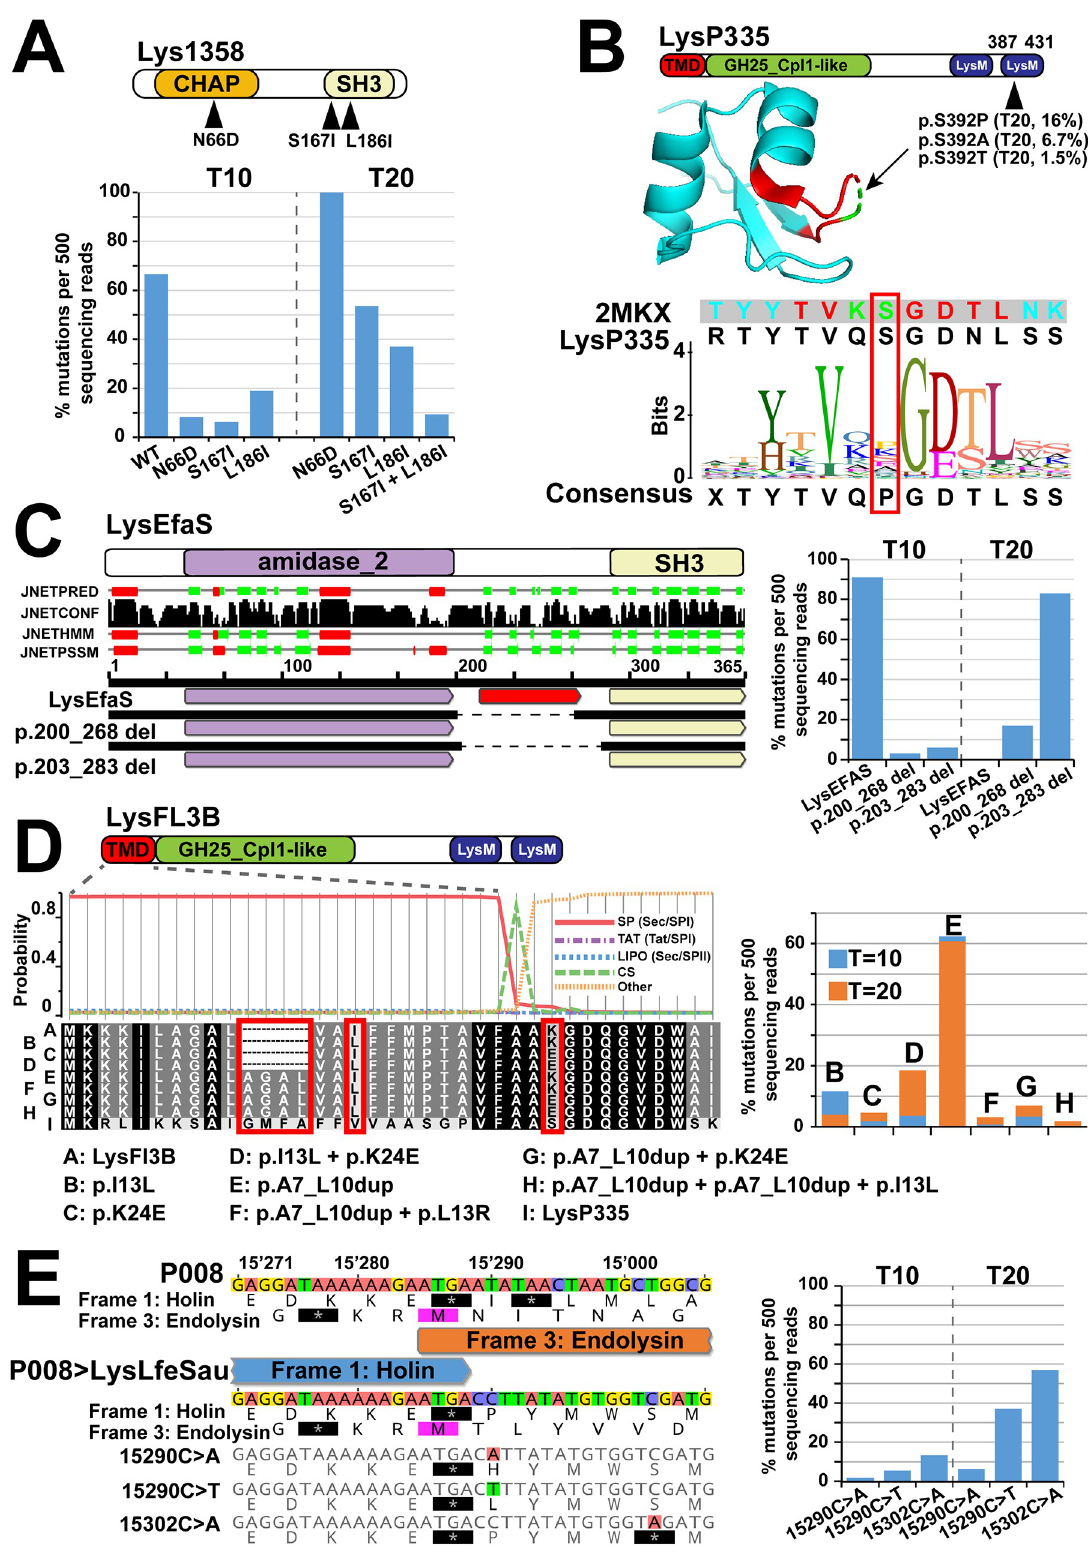
Fig 8. Genomic changes after experimental evolution of phage P008 with different endolysins after 10 and 20 transfers. (A) Three mutations (N66D, S167I, and L186I) were observed in the CHAP CD or SH3 CBD of the P008 > Lys1358 mutant and appeared